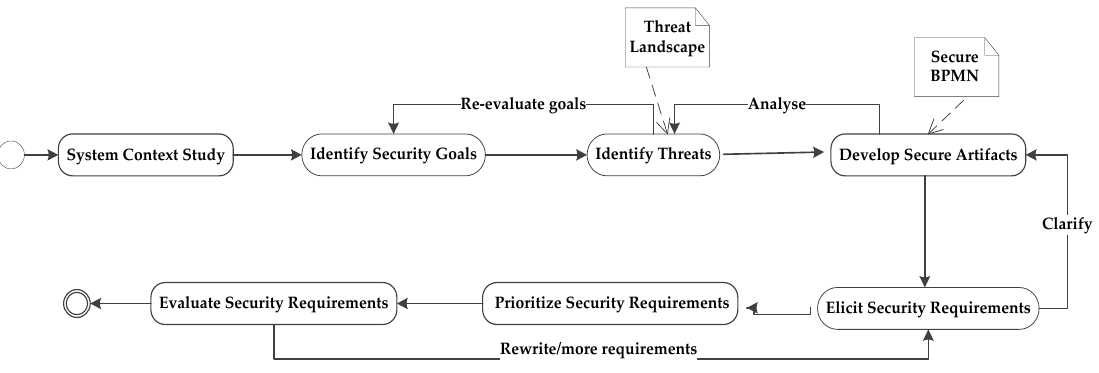
Figure 1. Security requirements framework using the threat profile technique and BPMN extension